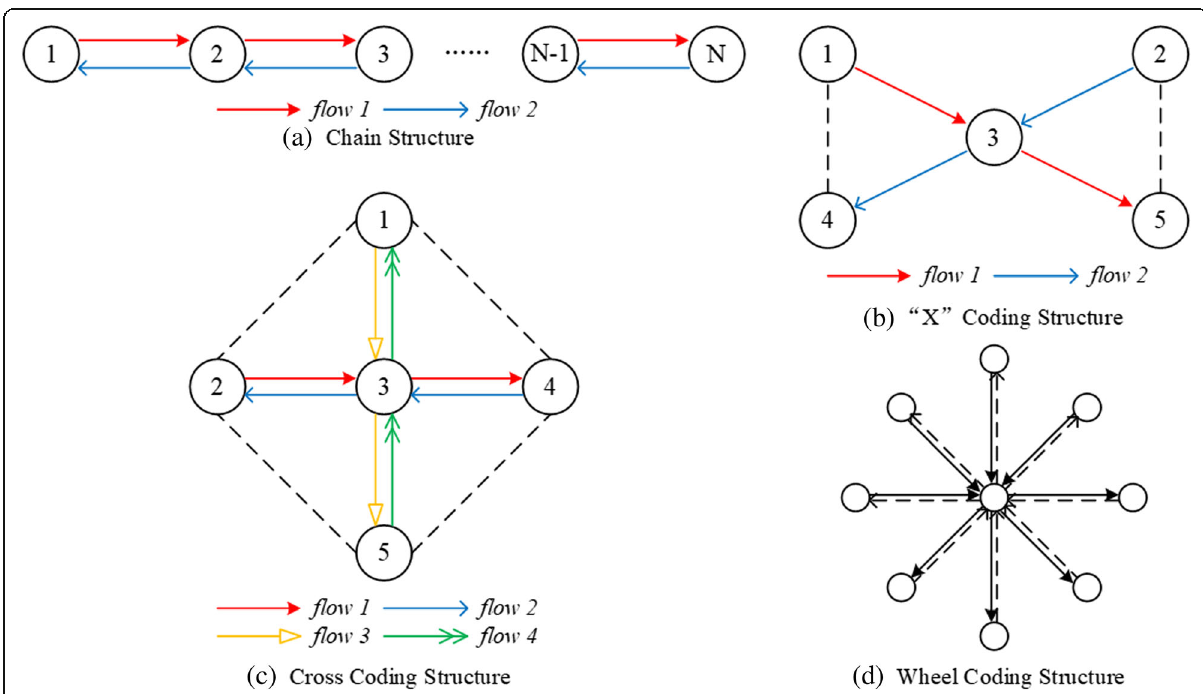
Fig. 2 Classical coding structure with One Hop Range in COPE. Figure 2 shows the classical coding structure existing coding opportunity in COPE, which can be classified as ( a ) chain structure, b “ X ” structure, c cross coding structure, and ( d ) wheel structure according to the shape of the coding